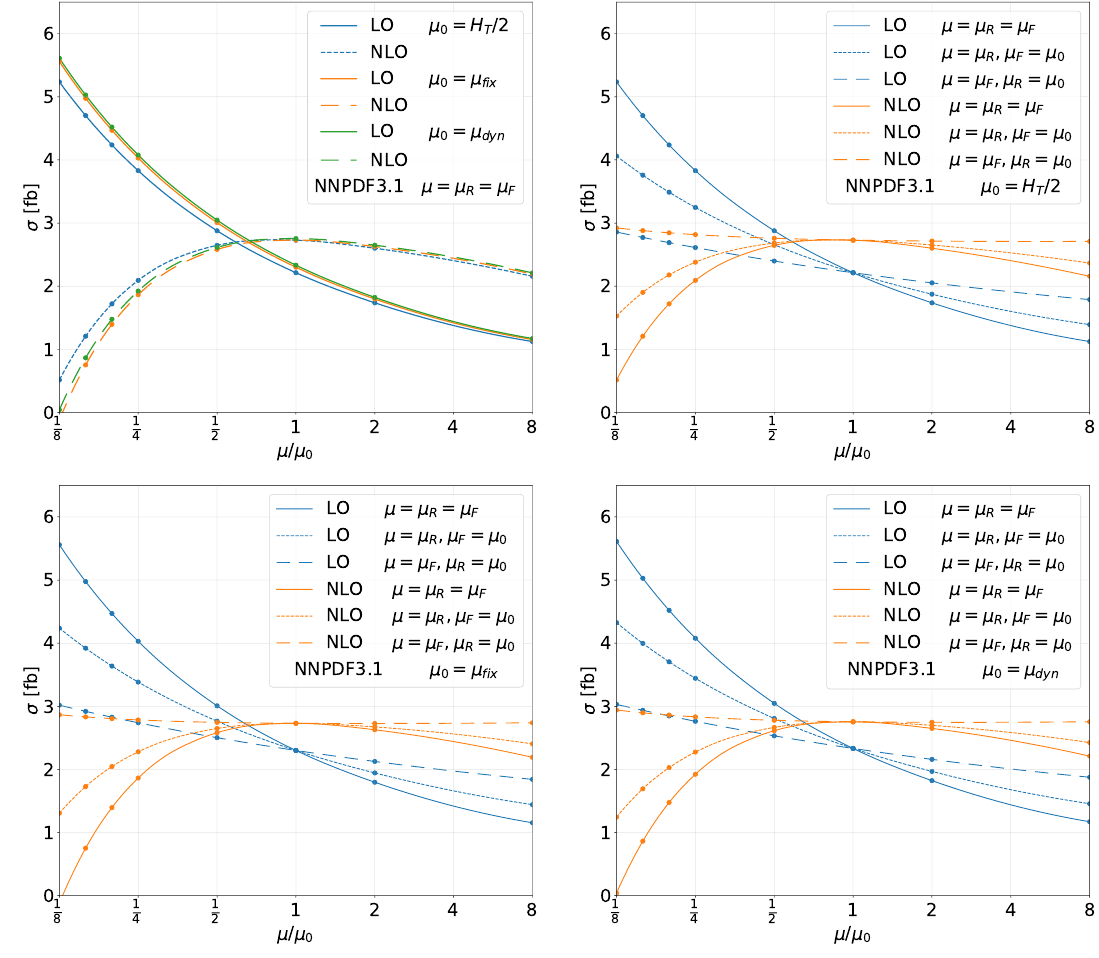
Figure 3 . Scale dependence of the integrated fiducial cross section at LO and NLO QCD for the √ pp → e + ν e µ − ¯ ν µ b ¯ b H process at the LHC with s = 13 TeV. Results are given for µ 0 = H T / 2 , µ 0 = µ fix and µ 0 = µ dyn as well as for the NNPDF3.1 PDF